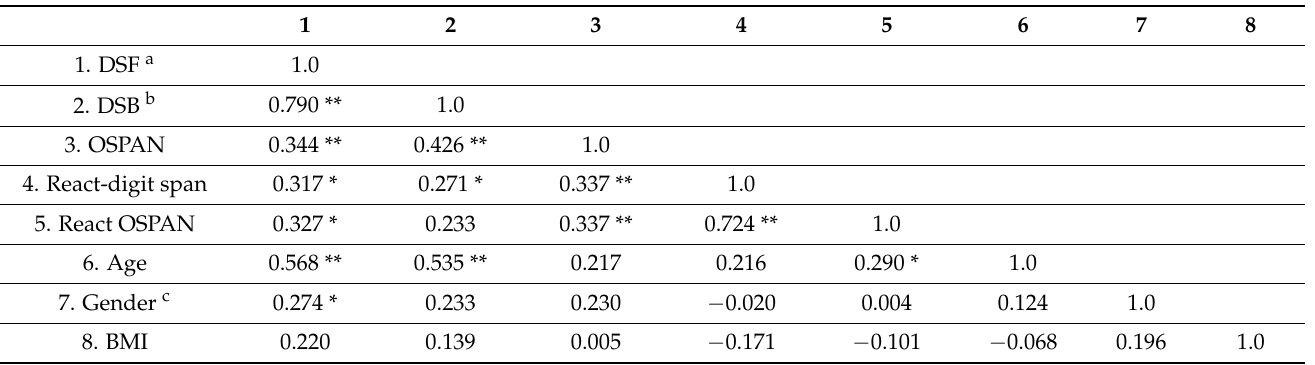
Table 2. Pearson’s bivariate correlation for task performance and potential predictor variables.